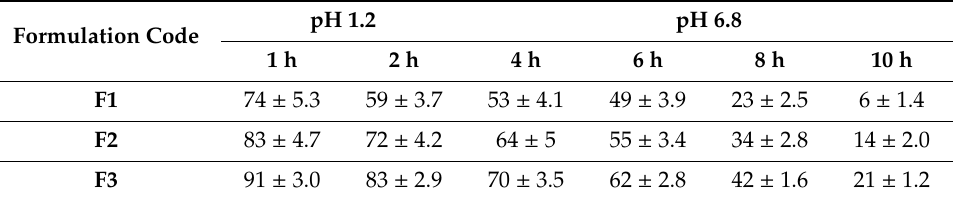
Table 6. Percentage of nanoparticles adhering to tissue at pH 1.2 and pH 6.8.